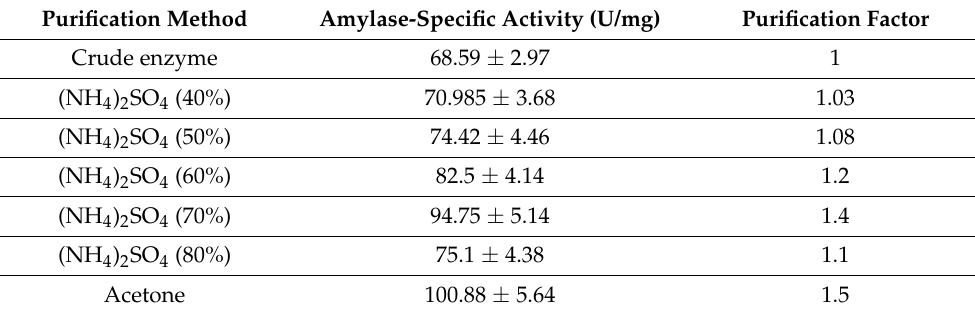
Table 6. Alpha-amylase-specific activity using different purification methods.